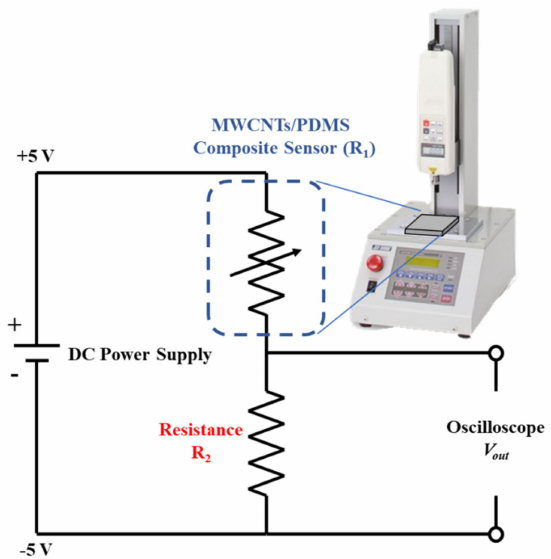
Figure 7. The linear conversion system architecture for signal output.